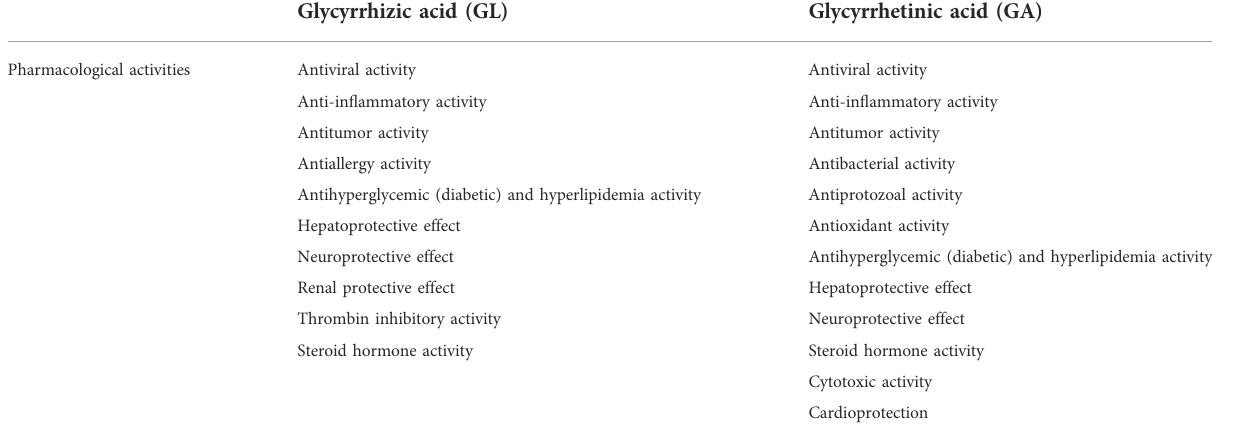
TABLE 3 Pharmacological activities of GL and